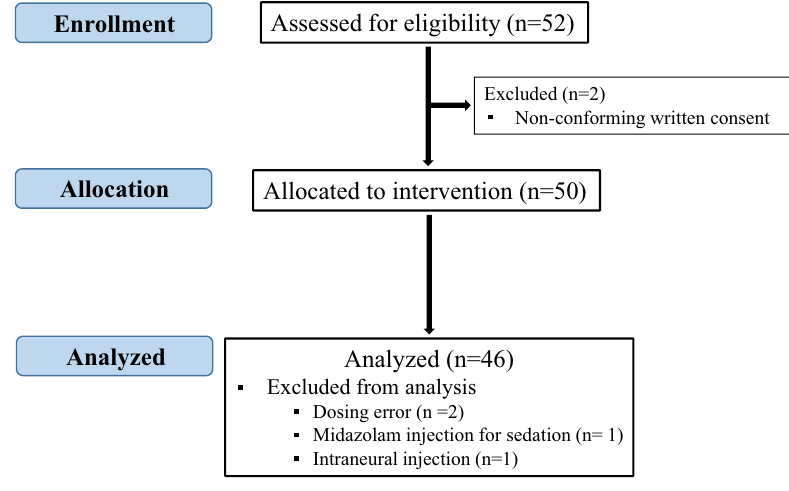
Figure 1. Flow chart.